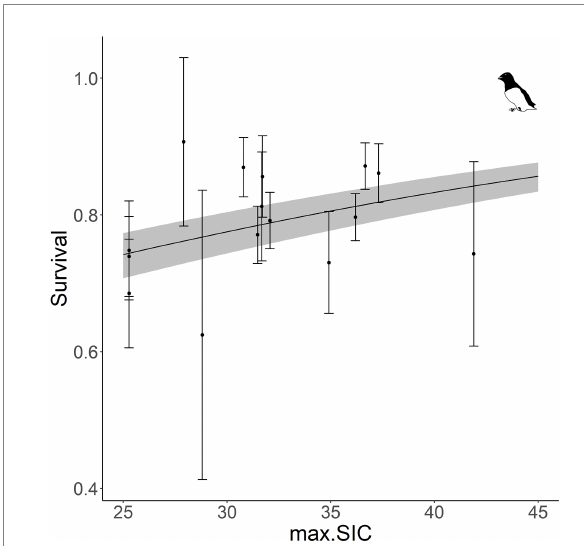
FIGURE 3 Survival of little auk modeled as a function of maximum sea-ice concentration (max. SIC , plain line) with 95% confidence intervals and annual estimates obtained from the time dependent model (filled circles) with standard error.